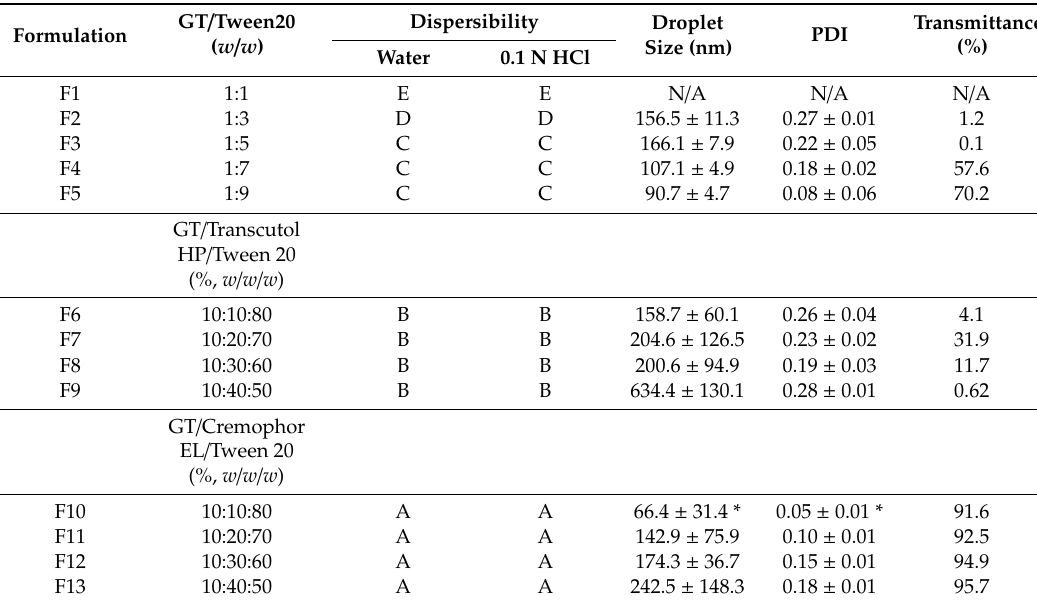
Table 1. Composition of SSM self-nanoemulsifying drug delivery system (SNEDDS) formulations and the results of the dispersibility test, droplet size, polydispersity index (PDI), and transmittance